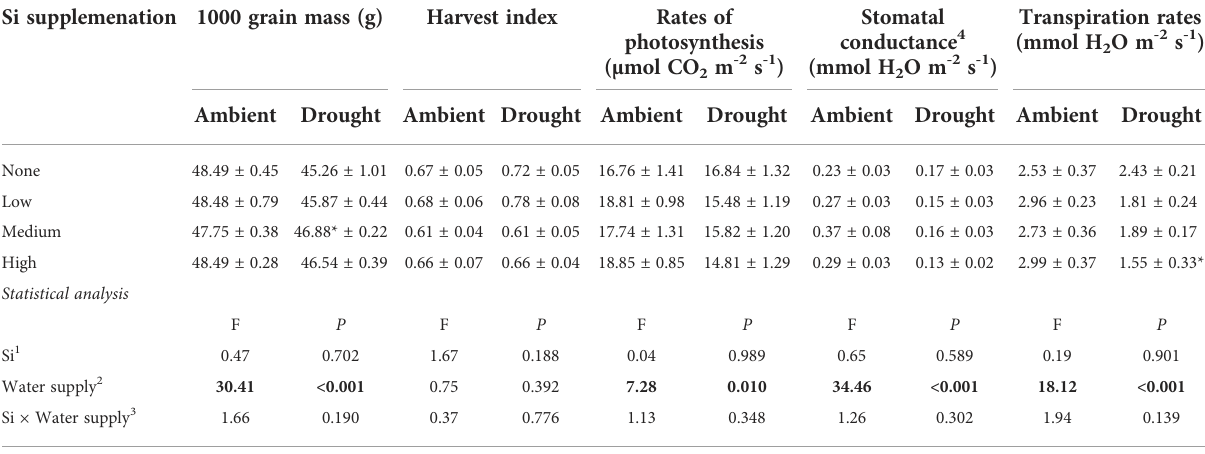
TABLE 4 Yield and leaf gas exchange responses to Si supplementation at three rates (low, medium and high) compared to non-supplemented plants (none) averaged across two sampling events. Si supplemenation 1000 grain mass